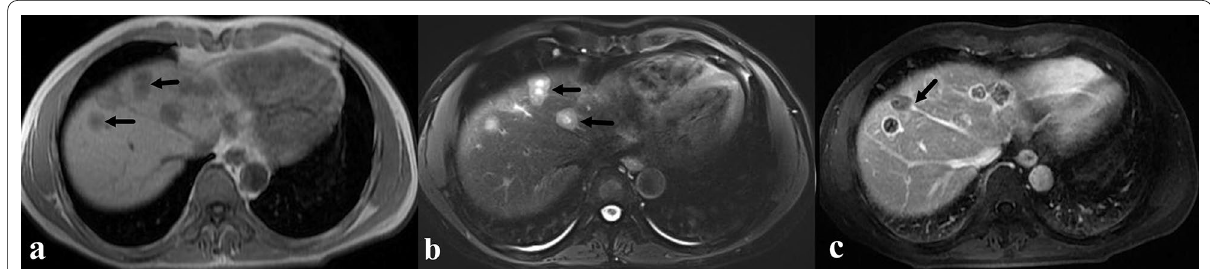
Fig. 1 A 42-year-old male HEH patient. a Coalescent lesion with target sign on T1-weighted 3D GRE image, consisted of concentric layers including markedly hypointense in central tumor regions and peripheral zones which were moderately hypointense relative to liver parenchyma (arrows). b Coalescent lesion with target sign on fat-saturated T2-weighted TSE image, consisted of concentric layers including markedly hyperintense in central tumor regions and moderately hyperintense peripheral zone (arrows). c Lollipop sign on portal phase image, consisted of a well-defined tumor (as the “candy”) and an obstructed hepatic vein (as the “stick”) (arrow)